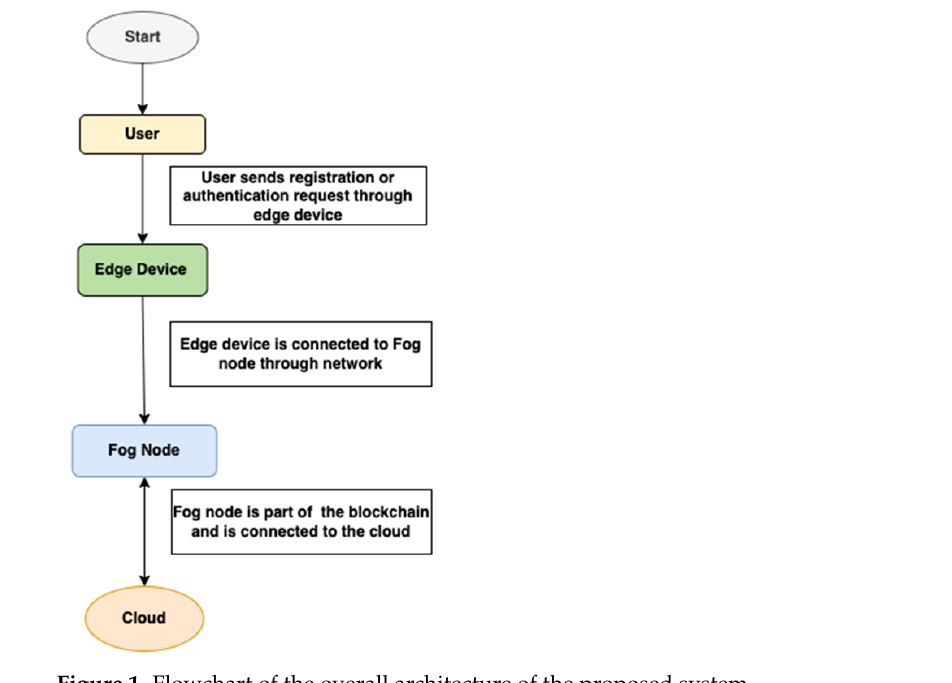
Figure 1. Flowchart of the overall architecture of the proposed system.